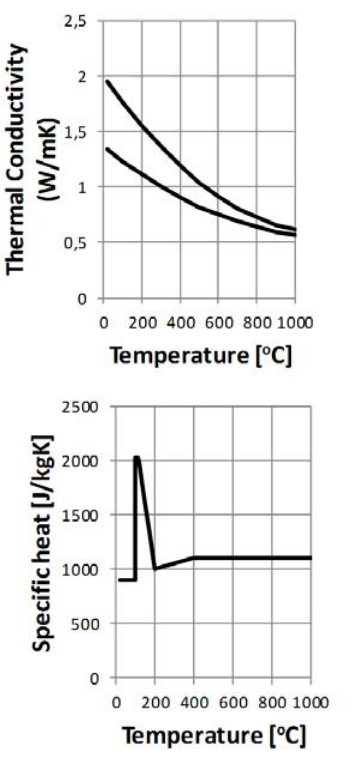
Figure 2. Thermal data from the Eurocode 1992 ‐ 1 ‐ 2 (2004) [25]. a) Temperature dependent thermal conductivity, lower and upper curve. b) Temperature dependent specific heat for concrete with 3% moisture.